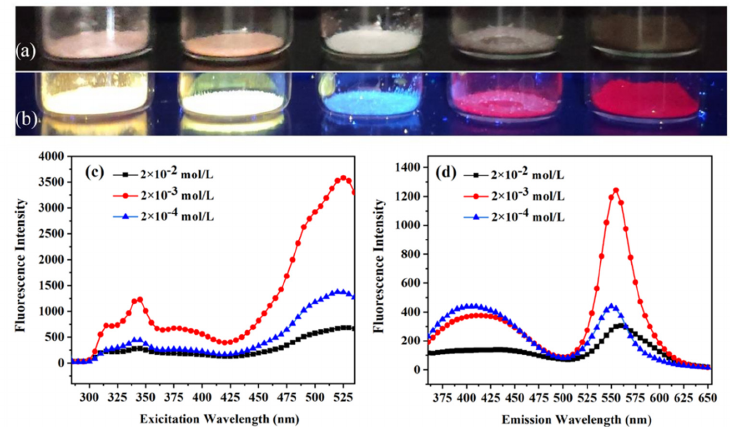
Figure 1. ( a ) Images of RhB@MOF-5 (RhB at a concentration of 2 × 10 − 3 mol/L), RhB@MOF-5 (RhB at a concentration of 2 × 10 -2 mol/L), MOF-5, RhB mixed with MOF-5 and RhB under visual light. ( b ) Images of RhB@MOF-5 (RhB at a concentration of 2 × 10 − 3 mol/L), RhB@MOF-5 (RhB at a concentra- tion of 2 × 10 − 2 mol/L), MOF-5, RhB mixed with MOF-5 and RhB under 365 nm UV light. ( c ) Fluo- rescence spectra (emission at 550 nm) for RhB@MOF-5 (RhB at concentrations of 2 × 10 − 2 , 2 × 10 − 3 , and 2 × 10 − 4 mol/L). ( d ) Fluorescence spectra (excitation at 340 nm) for RhB@MOF-5 (RhB at concen- trations of 2 × 10 − 2 , 2 × 10 − 3 , and 2 × 10 − 4